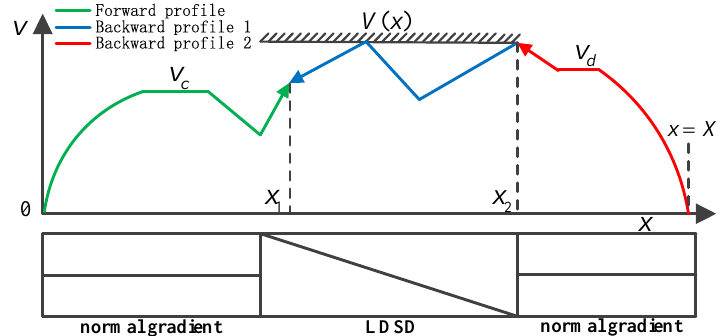
Figure 8. Forward and backward speed profile.